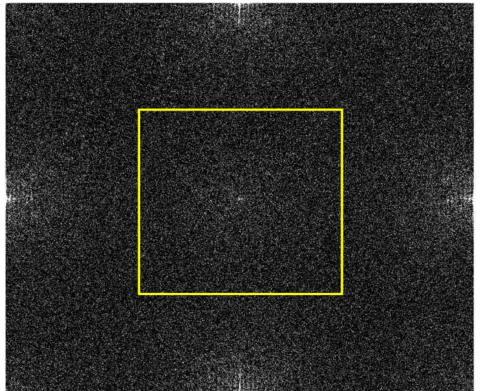
Figure 6. Frequency domain of a modulated shearogram and the window for selecting the lower